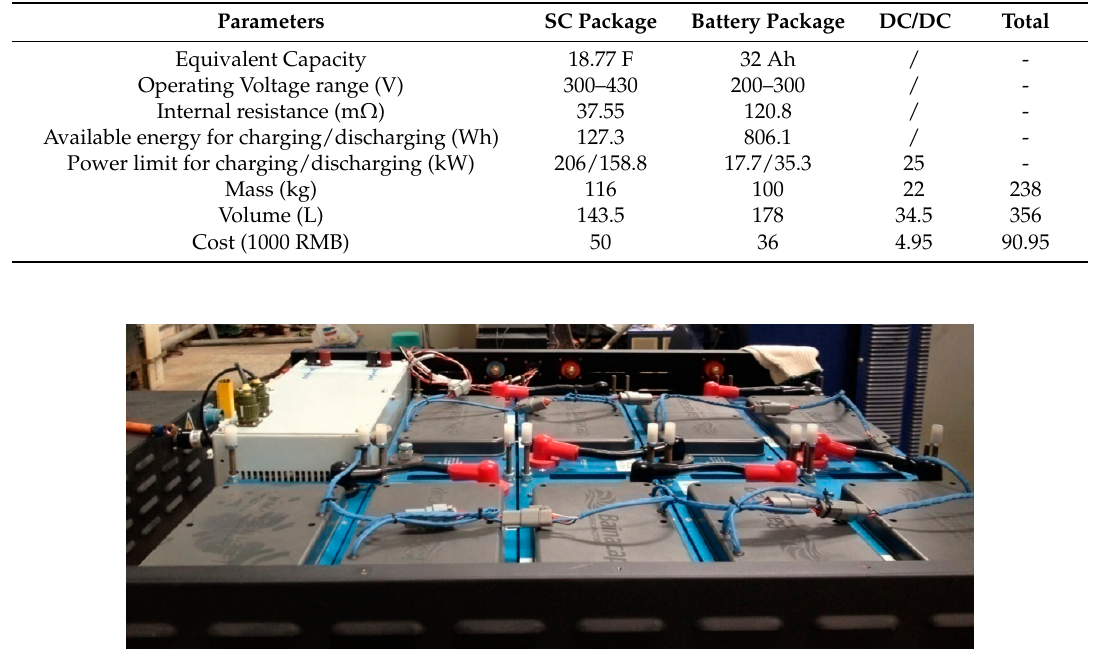
Figure 21. The arrangement of the SC package and DC-DC in our prototype.